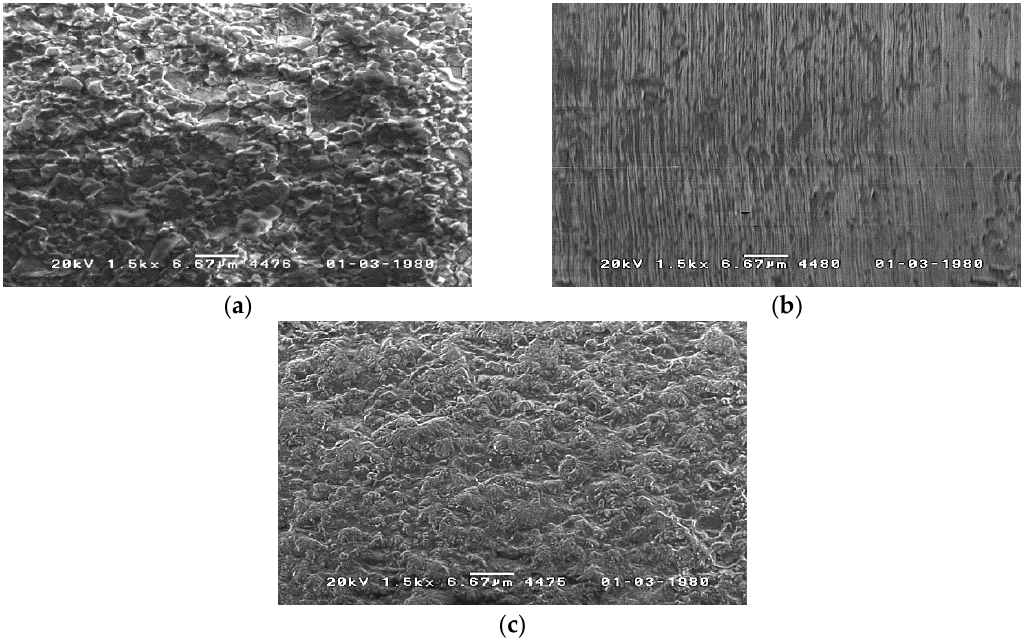
Figure 4. Surface conditions of workpieces before and after processing. ( a ) Before abrasive (0 s); ( b ) Diamond paste grain size 1 µm (270 s); and, ( c ) Diamond paste grain size 9 µm (270 s).